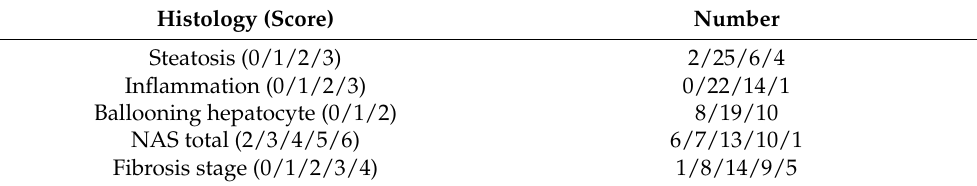
Table 2. Histological evaluation data of biopsy-confirmed NAFLD